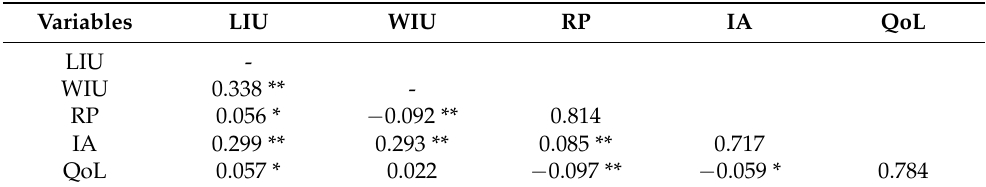
Table 3. Correlations for LIU, WIU, RP, IA, and QoL ( n = 1535). Variables LIU